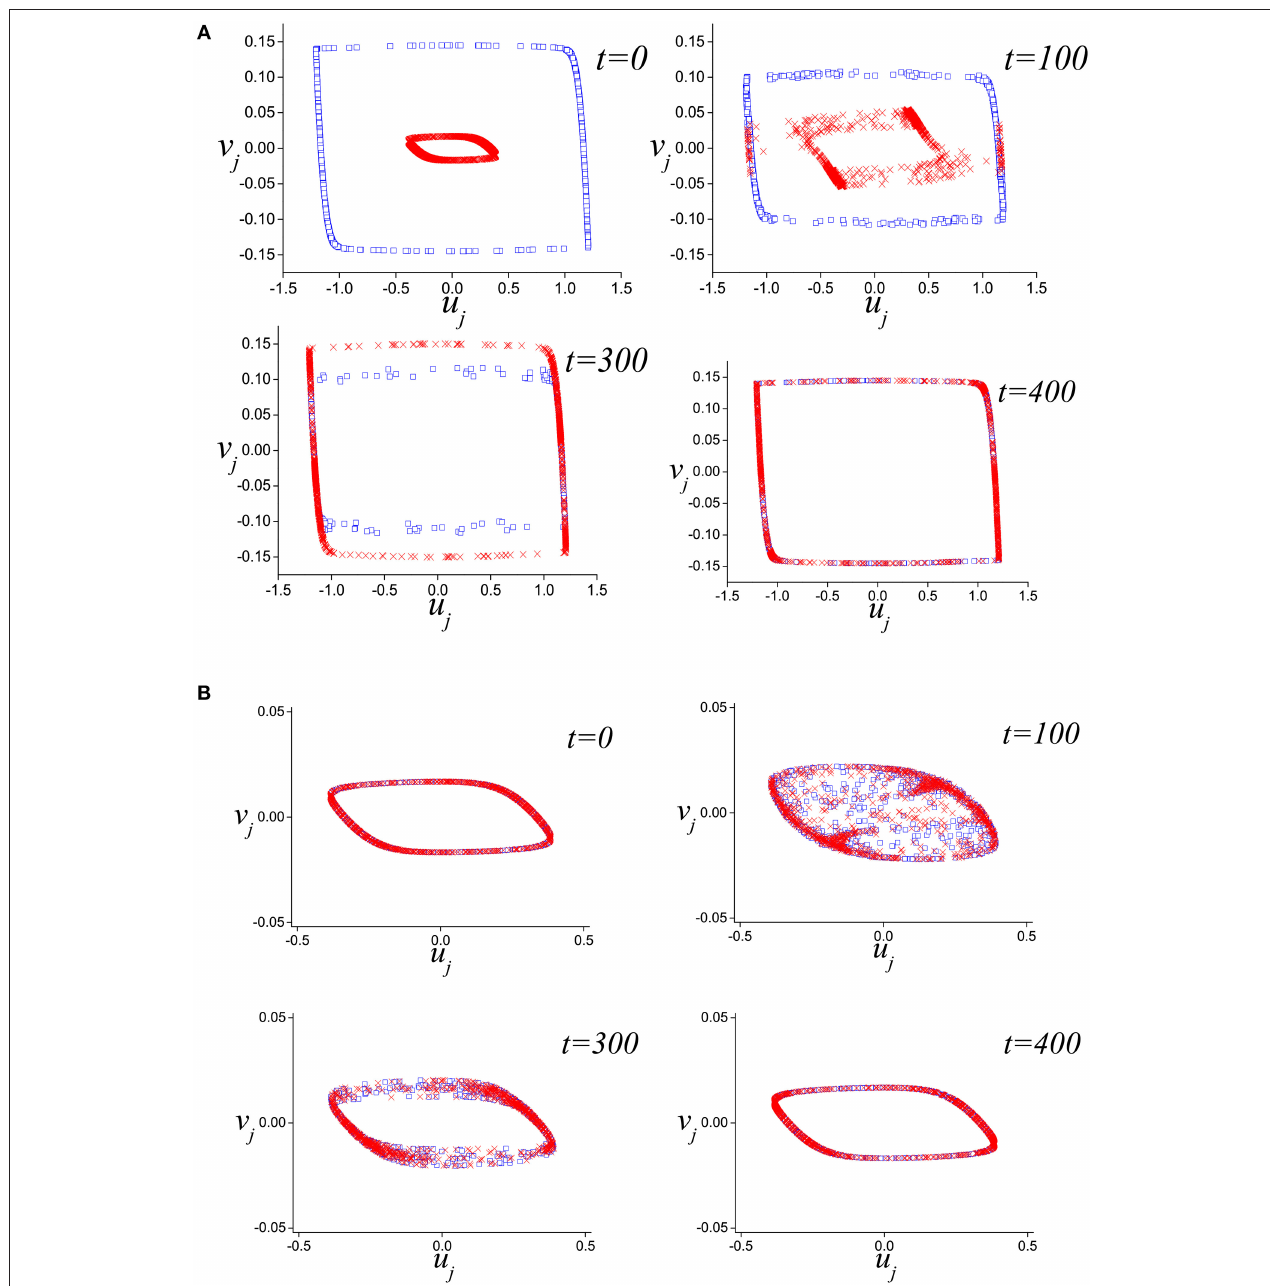
FIGURE 8 | Temporal snapshots of the pair of short-term coupled elements [system (3)] for 1,000 initial conditions such as (A) ( I . C .) 1 ; (B) ( I . C .) 2 . Parameters values: a = 0.32, b = 0.79, c = 1.166, ε = 0.001, d = 0.06, and T c =